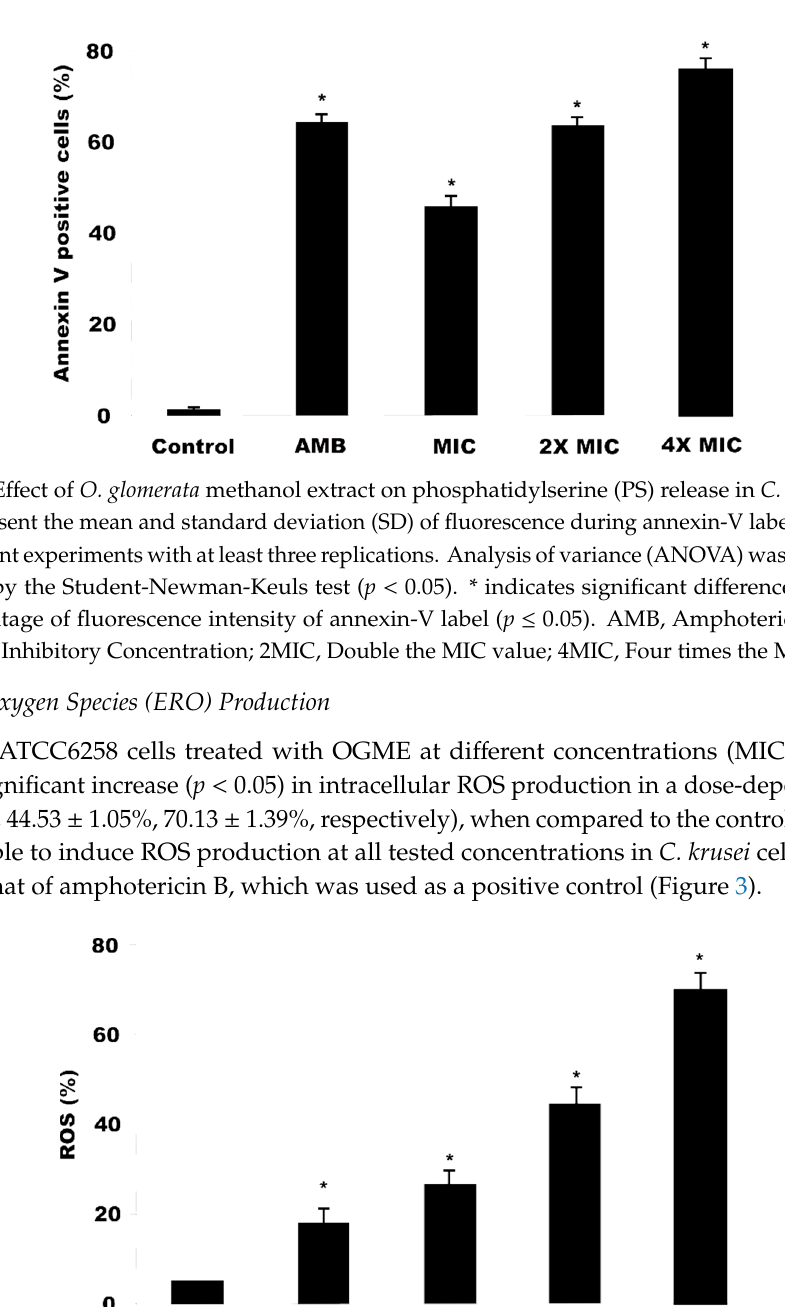
6 of 12 Figure 1. Effect of O. glomerata methanol extract on C. krusei cell viability using Propidium Iodide (PI). Data represent the mean and standard deviation (SD) of fluorescence during PI staining in two independent experiments with at least three replications. Analysis of variance (ANOVA) was performed followed by the Student-Newman-Keuls test ( p < 0.05). * indicates significant differences between the fluorescence intensity percentage of the staining with PI ( p ≤ 0.05). AMB, Amphotericin B; MIC, Minimum Inhibitory Concentration; 2MIC, Double the MIC value; 4MIC, Four times the MIC value. 2.6. Detection of Phosphatidylserine (PS) in C. krusei Cells Induced by Methanol Extract Phosphatidylserine (PS) release is an early event of cells entering apoptosis. In yeasts, PS is predominant in the internal monolayer of the lipid bilayer of the cytoplasmic membrane and is translocated to the outer monolayer during apoptosis [31]. Annexin V, a phospholipid binding protein with high affinity due to polarity loss, capable of binding to the released PS, was used for PS detection [32]. Figure 2 shows the results obtained for OGME treatments against C. krusei marked